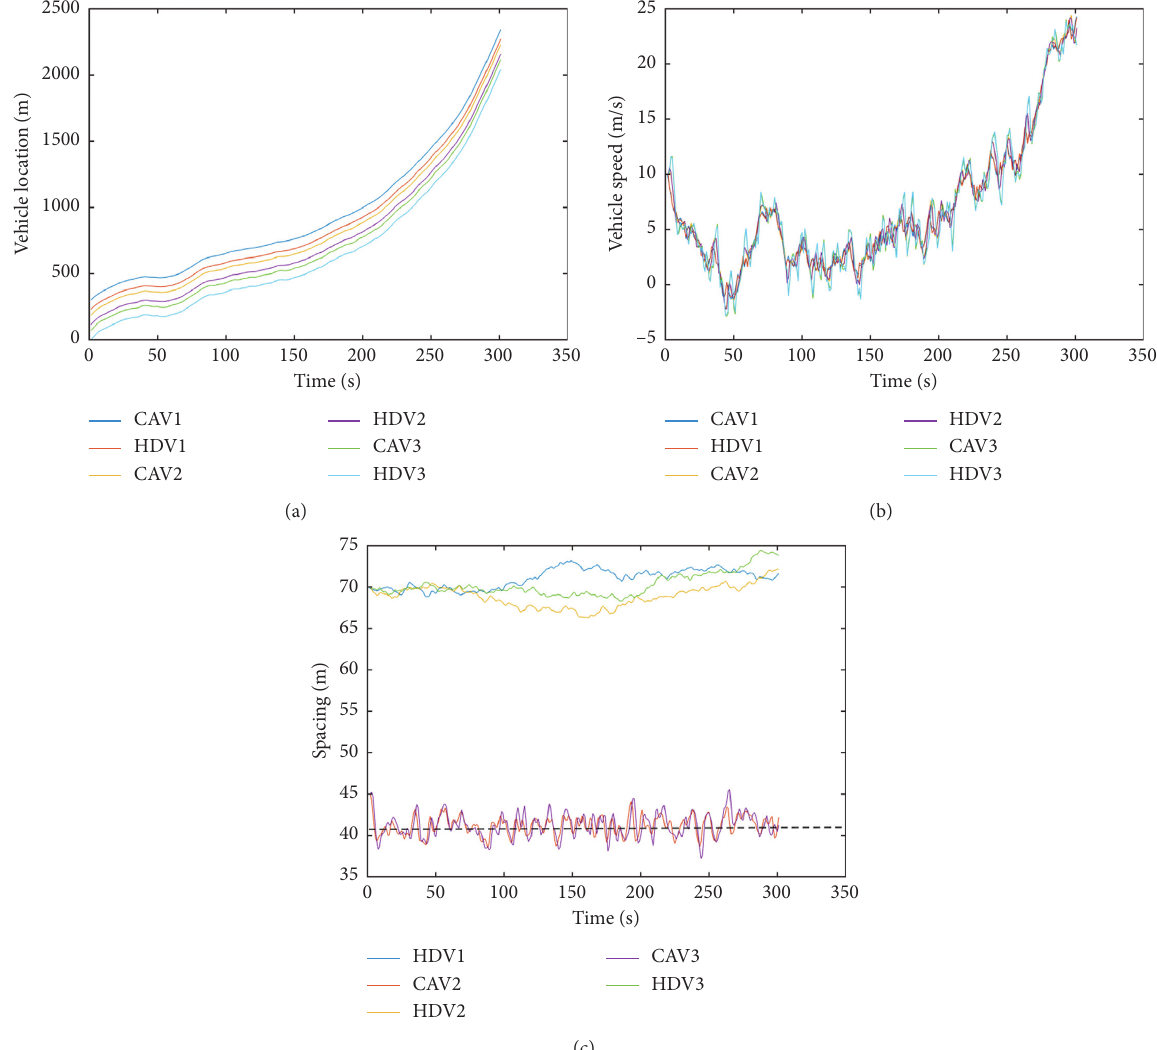
Figure 8: The fleet in dense fog environment with the visibility being 90m. (a) The location of formation. (b) The speed of formation. (c) The spacing of